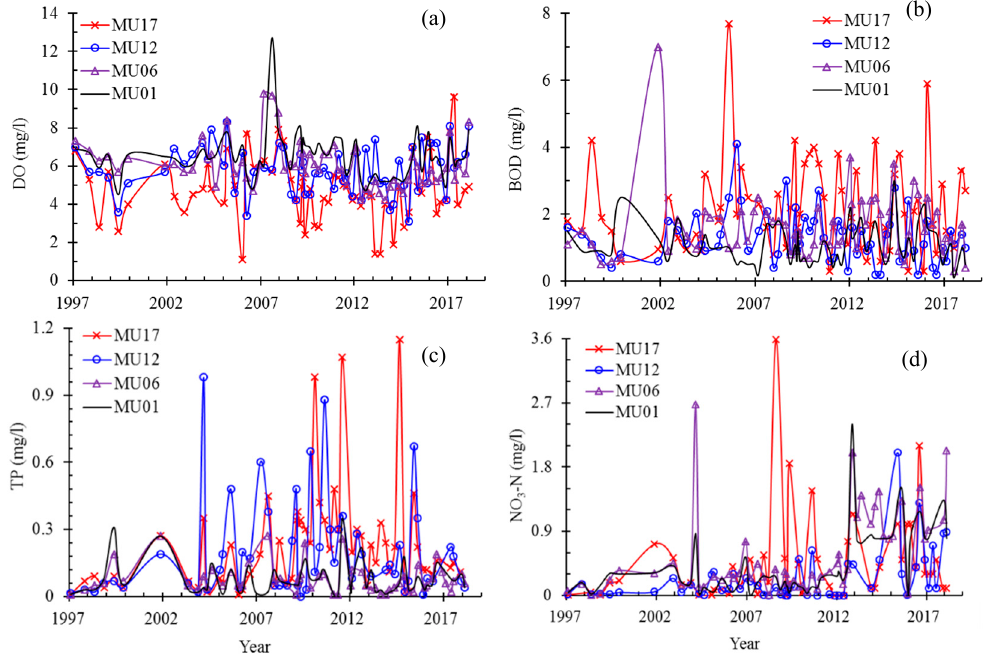
Figure 3. Temporal variation of typical parameters DO ( a ), BOD ( b ), TP ( c ), and NO 3 -N ( d ) at four monitoring sites along the Mun River during the past two decades (1997–2017).